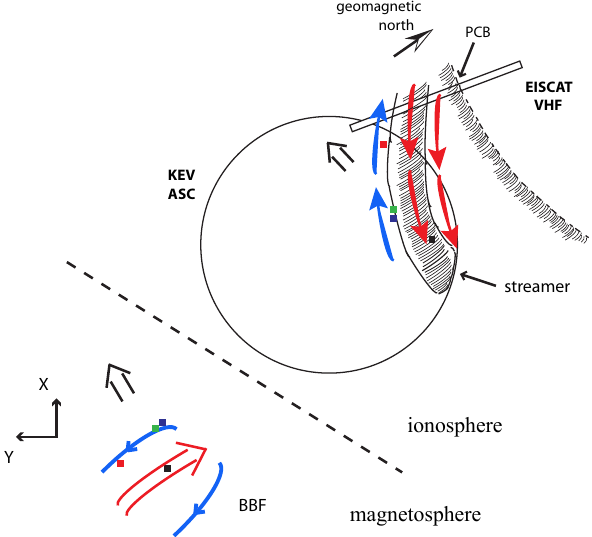
Fig. 9. Schematic illustration of the situation in the ionosphere and possible configuration of the BBF in the tail close to the XY GSM plane at ∼ 18:31–18:34UT when C1 sees the BBF 2 proper flow (see also Fig. 8d). Red arrows indicate the BBF proper flow and blue arrows the return flows. Wide black open arrows indicate the drift direction of the flow